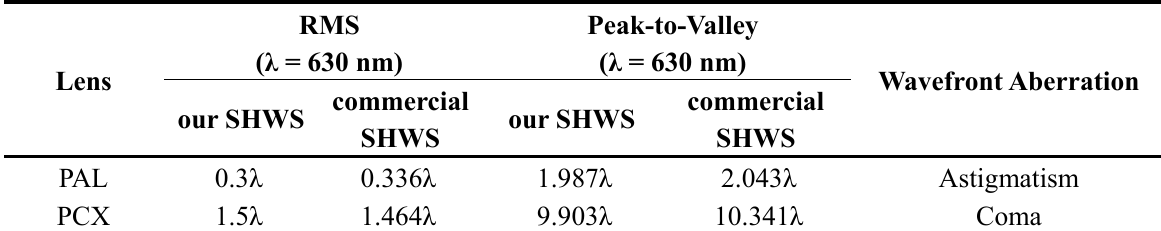
Table 3. The comparison of wavefront measurement by our SHWS and commercial